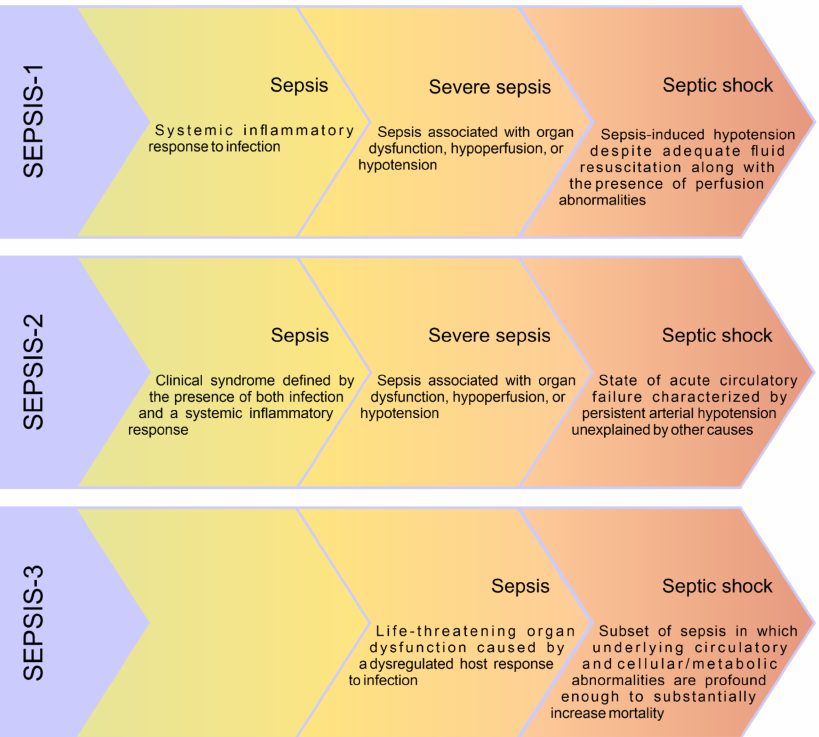
Figure 5. Comparison of old and new sepsis definitions. The first definition of sepsis and classification of clinical conditions associated with it were presented as a result of the American College of Chest Physicians (ACCP) and Society of Critical Care Medicine (SCCM) conference in 1991 (SEPSIS-1) [71]. Due to reservations, mainly related to the non-specificity of the definition of systemic inflammatory response syndrome (SIRS), a conference called SEPSIS-2 was organised in 2001, during which the definitions established during SEPSIS-1 were maintained and an extended list of possible symptoms of systemic inflammation in response to infection was proposed [68]. A further need to update the sepsis nomenclature led to the publication of The Third International Consensus Definitions for Sepsis and Septic Shock (SEPSIS-3) in 2016, including new definitions of sepsis and septic shock